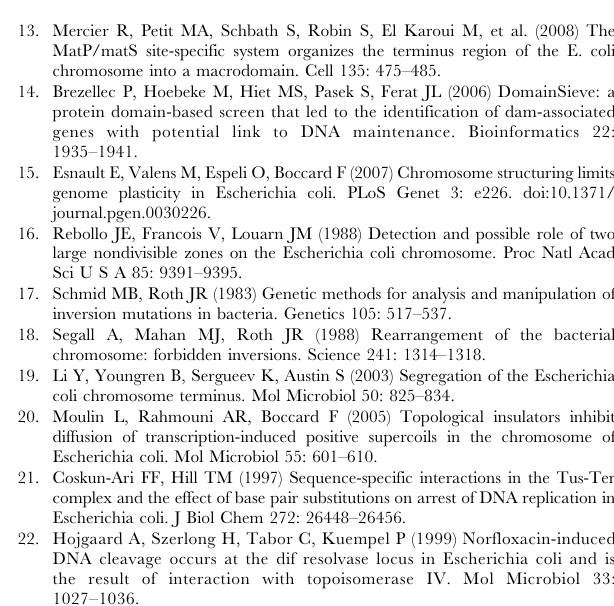
Figure S1 PCR reactions to control the transposition reaction generating strain LC13-R127-B O-NSR . (A) Schematic map of att sites in strain LC13-R127 before and after transposition. To control the result of the transposition reaction, 5 pairs of primers flanking the att sites were used (black arrows). Pairs 1 and 2 amplify respectively the att B and att R sites of the chromosome in its original configuration. Pairs 3, 4 and 5 flanked the att R 9 , att L 9 and att B 9 sites in the stain after transposition (details will be given upon request). (B) Gel electophoresis of PCR products generated with the genomic DNA of the LC13- R127-B O-NSR strain before (WT) and after transposition (T). Figure S2 Physiology of the R127-LC13-B O-NSR transposed strain. (A) Cells were grown until OD 0.2 in LB, fixed and DNA stained with DAPI as described before (Esnault et al., 2007). Percentage of cells in each size category according to their number of nucleoids in the wild type strain (left) and the transposed LC13- R127-B ONSR strain (right). Coloured horizontal bars indicate the percentage of the different types of cells and nucleoids. Cell size is indicated. Green indicates cells containing one and two nucleoids; yellow: cells containing four nucleoids; cyan: cells containing par - like nucleoids; red: cells with unsegregated nucleoid. (B) Co-culture competition assay between the wild type strain and the LC13- R127- B O-NSR transposed strain. The strain with the NS Right region transposed was grown in serial co-cultures with the wt